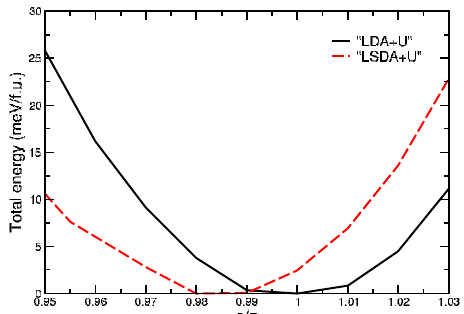
Fig. 5 Total energies as obtained in DFT + U + SOC with two different implementations of the + U term (black curve - spin- polarization is allowed only in “ U ” part, so-called LDA + U; red - spin polarization is possible in both DFT and “ U ” parts, LSDA + U ). Minimum at c / a = 1 corresponds to SOC J eff = 1/2 state, while at c / a < 1 to Jahn-Teller S = 1/2. These results illustrate that the type of ground state strongly depends on the details of the DFT